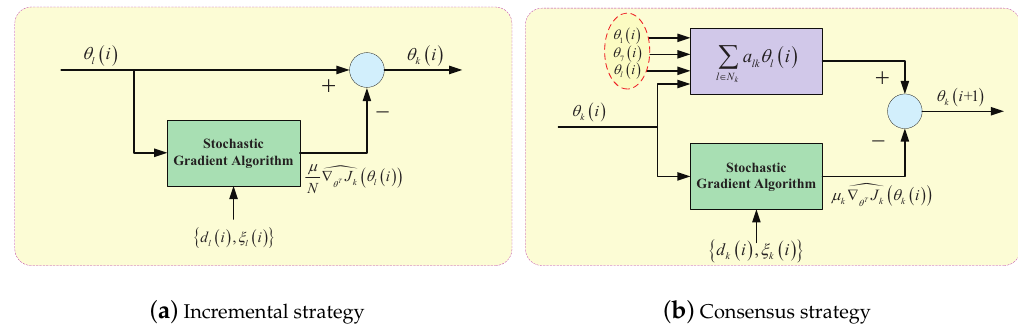
Figure 4. Two types of distributed estimation with cooperative strategy: incremental strategy and consensus strategy. ( a ) A cyclic path with increment strategy is the start of node l , in which all intelligent nodes can be visited in Figure 3. ( b ) The neighbors of intelligent node k with consensus strategy is defined as { 1,7, l , k } .